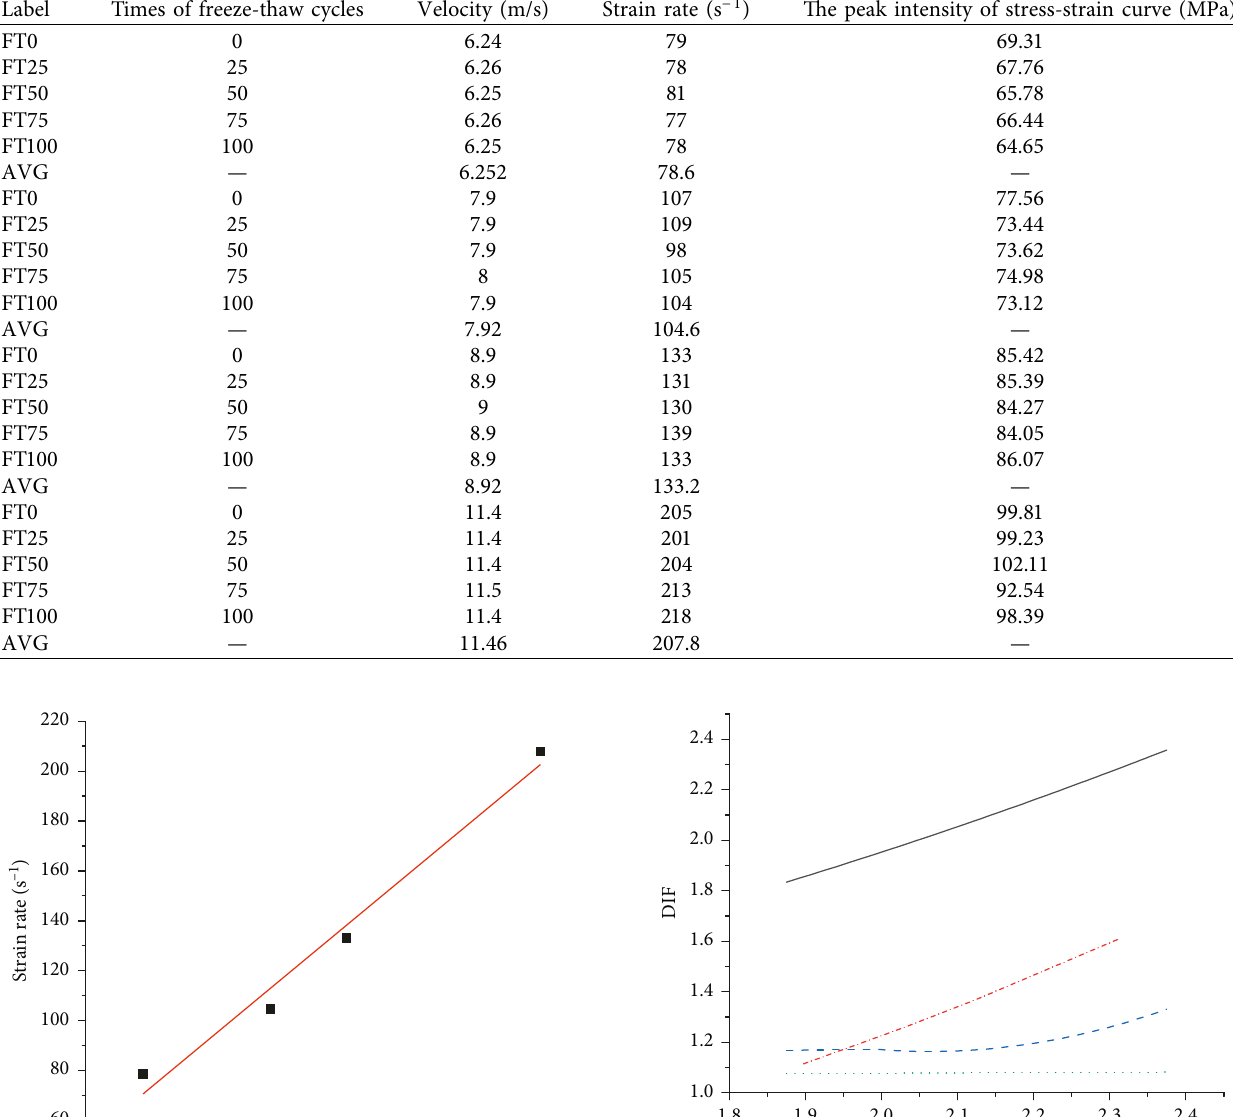
Table 3: Dynamic compression test results.